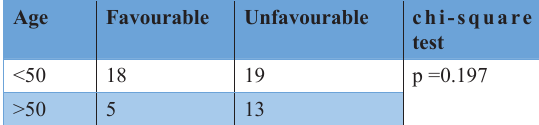
Table 4. Relation between age &